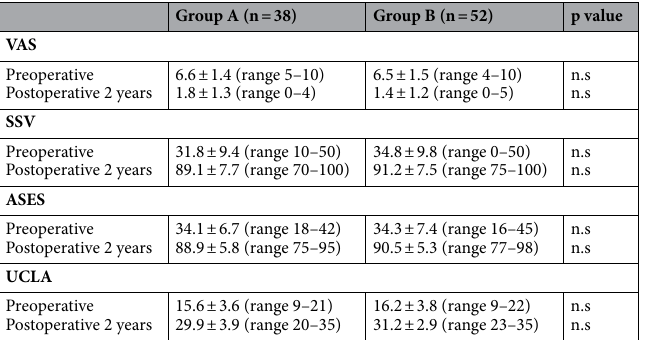
Table 2. Visual analog scale (VAS) pain score, American Shoulder and Elbow Surgeon (ASES) score, and University of California Los Angeles (UCLA) shoulder scores for both groups. The values are given as means and standard